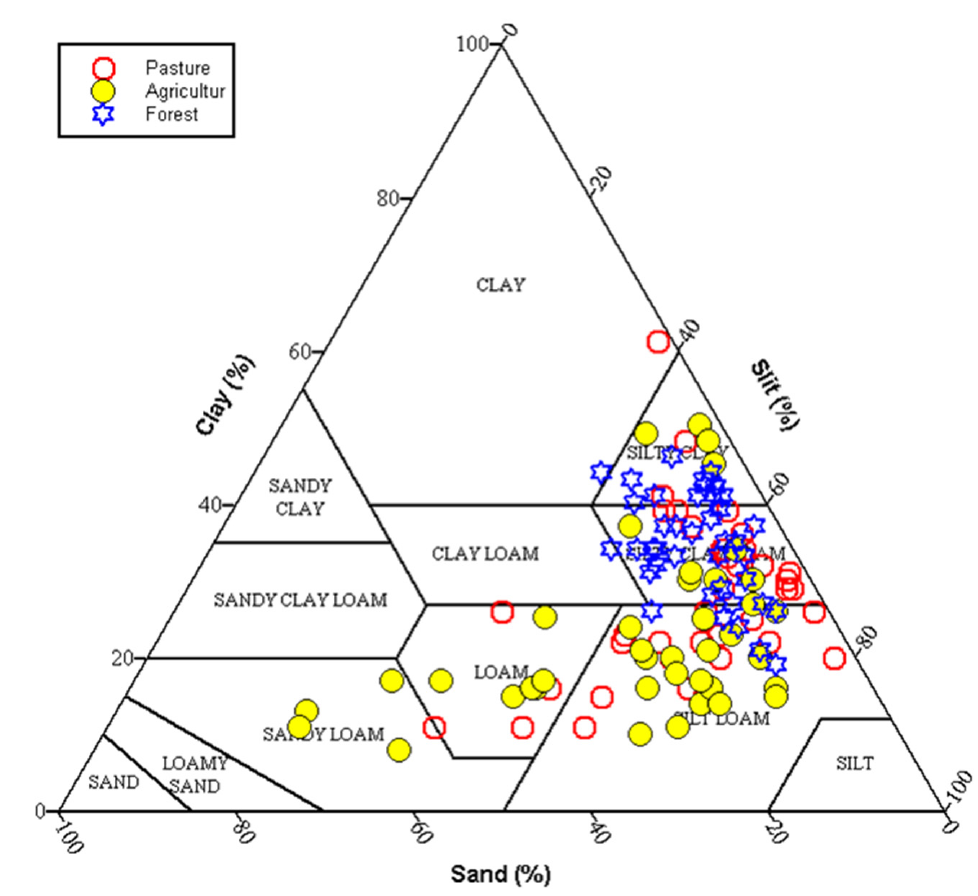
Figure 2. Soil textural classes of the soil samples under different land uses. Pearson’s correlation coefficient (r) was calculated for D and the measured soil proper- ties, which values are presented in Table 2. Soil pH is significantly positively correlated with CaCO 3 content (r = 0.76, p < 0.01), which is linked to the main soil type in the study region being chalky with a high lime content [28]. Soil clay content is positively correlated with the measured SOM (r = 0.40, p < 0.05) and CEC (r = 0.52, p < 0.05), which is consistent with the findings of Ostovari et al. [29] and Ostovari et al. [30]. Table 2. Correlation coefficient matrix for soil properties in the study region.